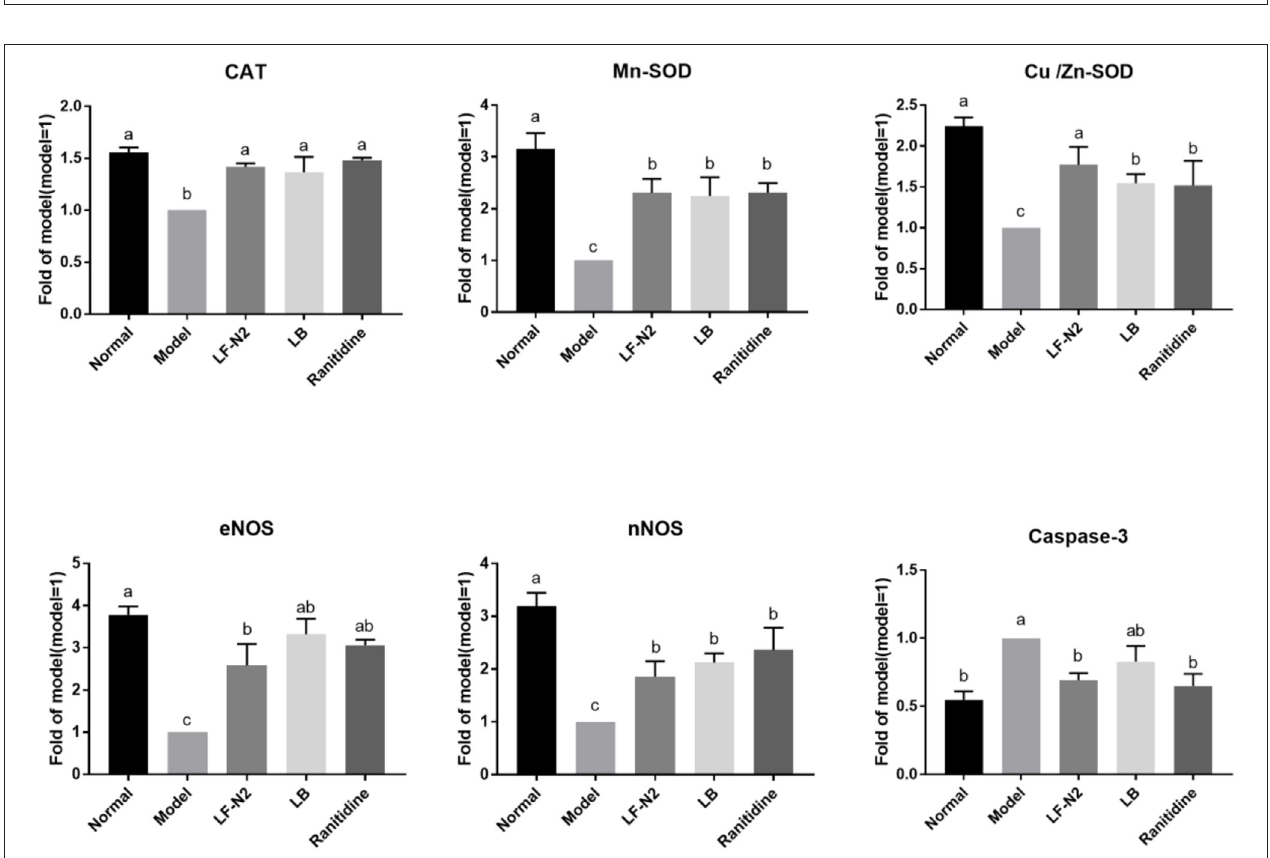
injury ( 20). In addition, it also includes the disorder of gastric mucosa microorganisms, oxidative damage caused by excessive production of oxygen free radicals, and inflammatory reaction caused by excessive production of nitric oxide (NO)